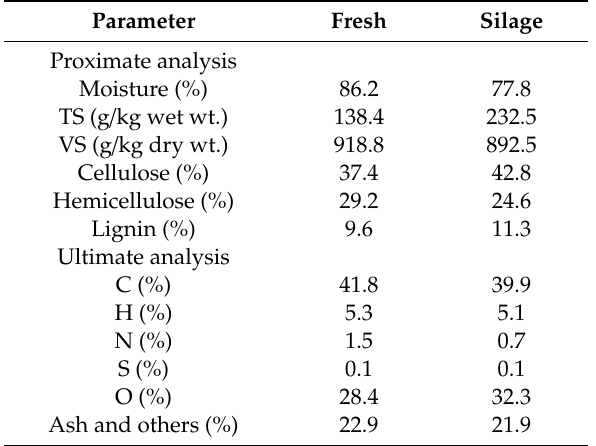
Table 1. Characteristics of fresh Napier grass and Napier grass silage used in the experiments.